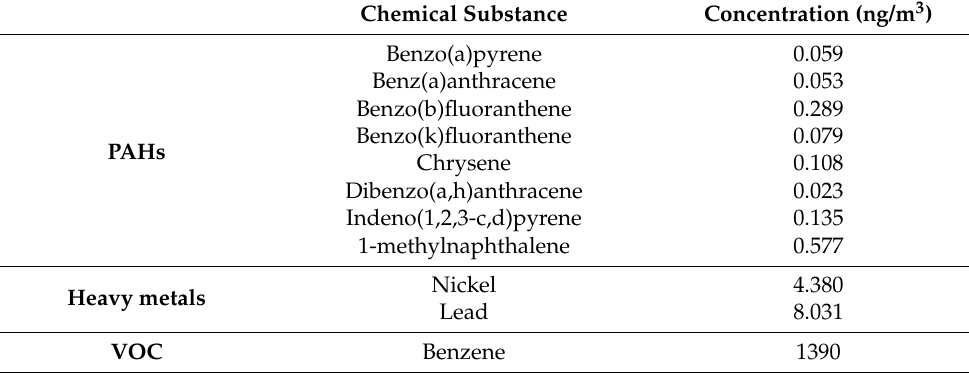
Table 3. Average concentration of measured pollutants in Elefsina